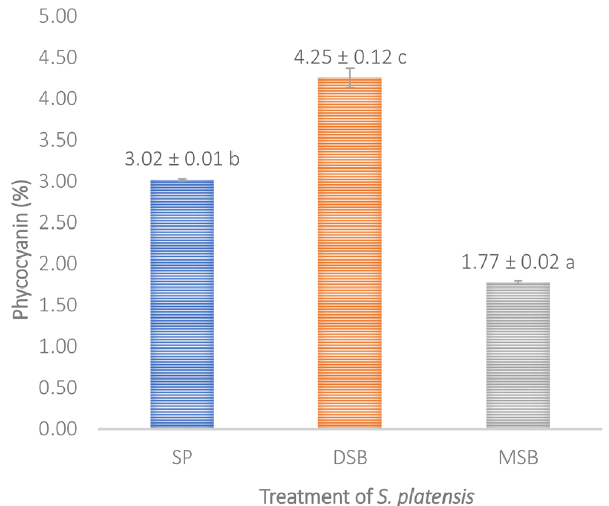
Figure 5. Phycocyanin content (n=3, mean value ± standard deviation; different superscripts indicate a significant difference). SP = S. platensis with no treatment, DSB = S. platensis traeted with freeze-dried O. basilicum , MSB = S. platensis treated with microencapsulation freeze-dried O. basilicum .